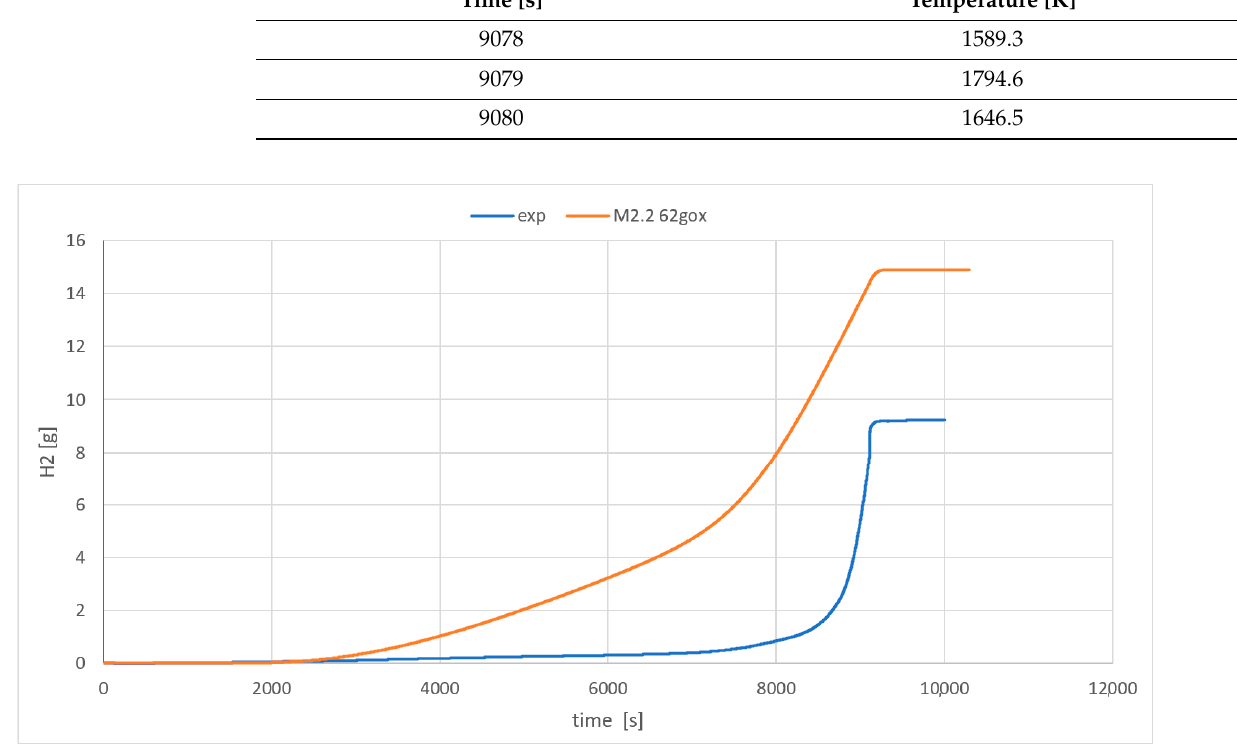
Figure 14. Comparison of the amount of hydrogen produced in the experiment and the MELCOR calculation results [12].